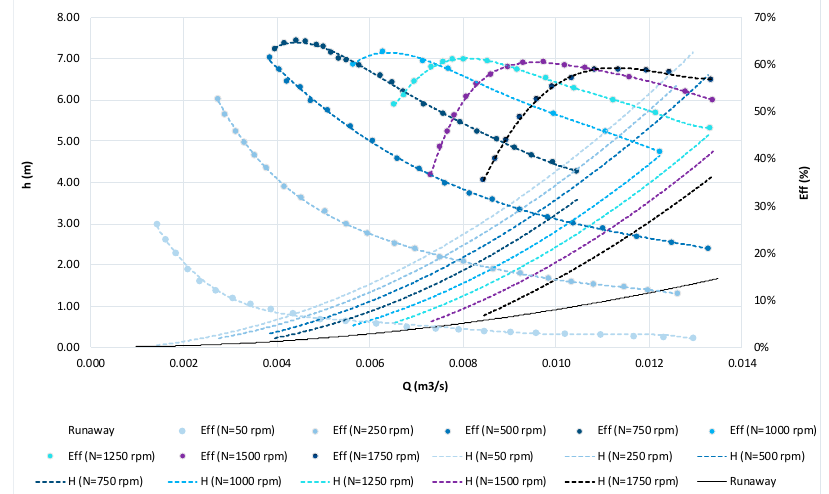
Figure 2. Experimental results of the performance assessment (turbine propeller with D = 85 mm).